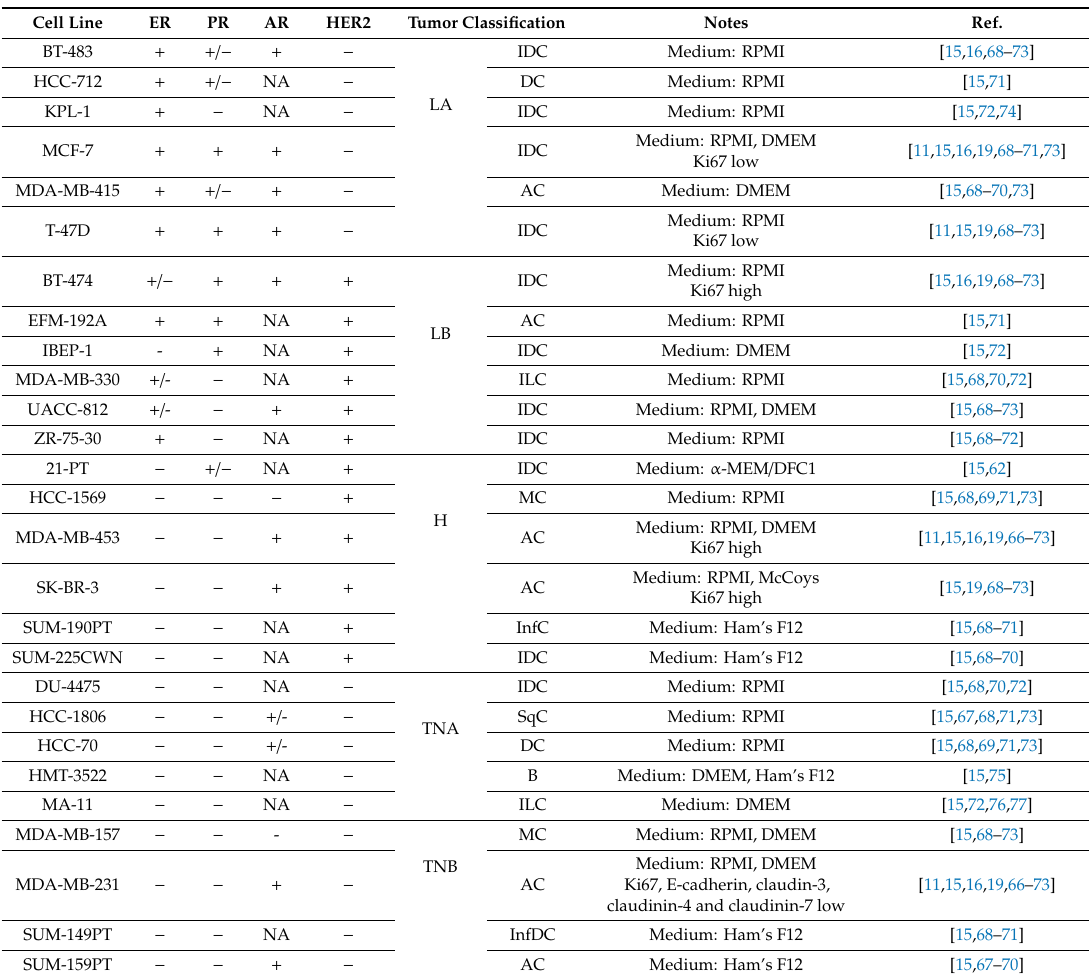
Table 2. Characterization of breast cancer cell lines based on the receptors they express: Estrogen Receptor (ER), Progesterone Receptor (PR), Androgen Receptor (AR), and Human Epidermal Growth Factor Receptor 2 (HER2); and classification of the tumor they origin, into breast cancer subtypes depending on the receptors they express: Luminal A (LA), Luminal B (LB), HER2 Enriched (H), Triple-Negative A or basal-like (TNA), and Triple-Negative B or normal-like (TNB); and on their histopathological features: benign tumor (B), adenocarcinoma (AC), ductal carcinoma (DC), invasive ductal carcinoma (IDC), invasive lobular carcinoma (ILC), inflammatory carcinoma (InfC), inflammatory ductal carcinoma (InfDC), medullary carcinomas (MC), or squamous carcinoma (SqC). Additional information on the culture medias more commonly used for each cell line: Ham’s F12 liquid medium (HAM’s F12), Dulbecco’s Modified Eagle’s Medium (DMEM), Roswell Park Memorial Institute (RPMI) medium and Minimal Essential Medium Eagle-alpha modified with nucleosides and DFC1 medium ( α -MEM / DFC1) [11,15,16,18,66–73]. Tumor